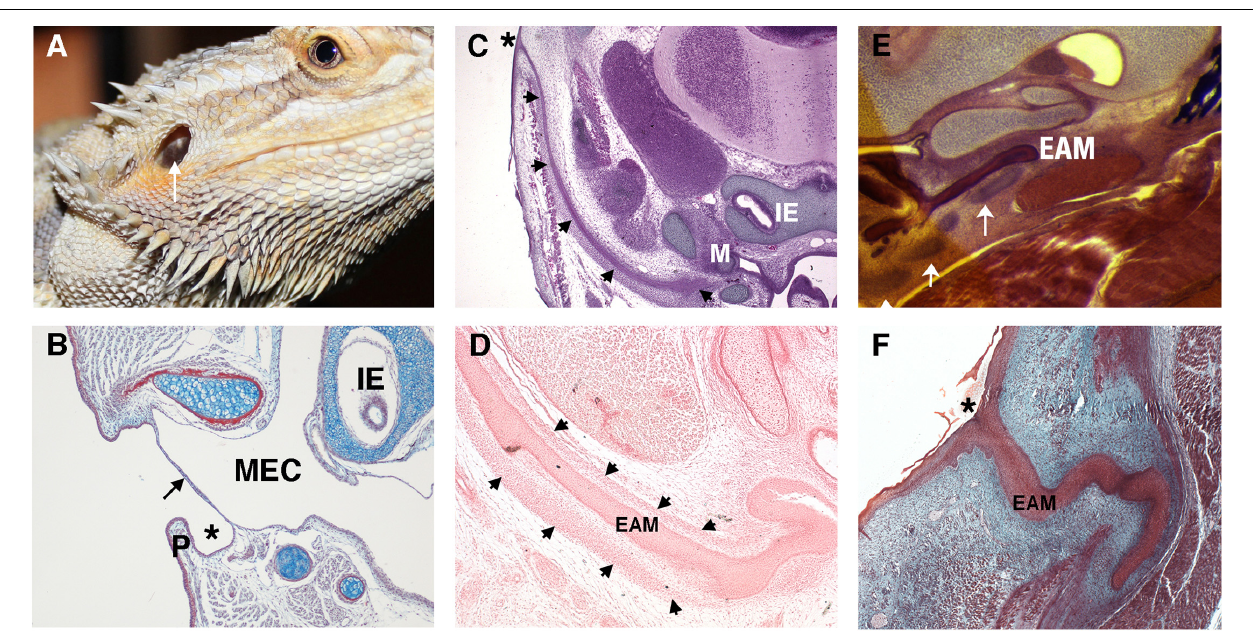
FIGURE 2 | Variations in the non-mammalian ear canal. (A) Bearded dragon ( Pogona vitticeps ) with superficial tympanic membrane outlined by arrow. (B–F) Histology sections. (B) Sagittal trichrome section of gecko ear showing a shallow ear canal (star) and superficial tympanic membrane (arrow). (C,D) Developing platypus ( Ornithorhynchus anatinus ) EAM (C) Frontal section of platypus ear at 2 days post hatching (2 p.h.). The developing ear canal (arrows) is long extending from extending form the top of the head to the malleus. There is no pinna at the canal opening (marked by *). (D) Frontal section of developing ear canal in 10 p.h. day platypus. The EAM develops in a sheath of condensed mesenchyme (arrows). (E,F) Developing echidna ( Tachyglossus aculeatus ) EAM (E) Horizontal section through the EAM of 55–65 p.h. (arrows) days echidna demonstrating cartilage support (arrows) around the developing EAM. (F) Horizontal trichrome section through EAM of an echidna at 18 p.h. days showing a tortuous path to the opening (star). P, Pinna; MEC, middle ear cavity; IE, inner ear; EAM, external auditory